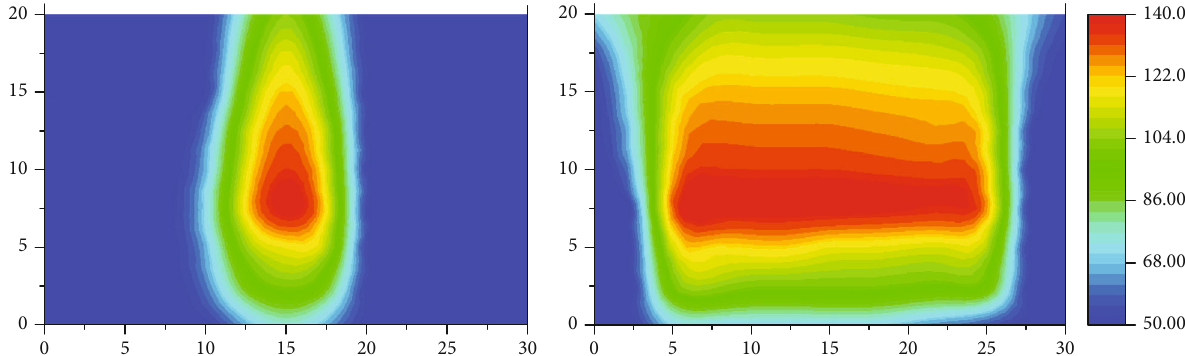
Figure 4: Temperature fi eld in the 3D model during the early stage of Experiment 1: (a) in the vertical direction of the wells and (b) along the wells.